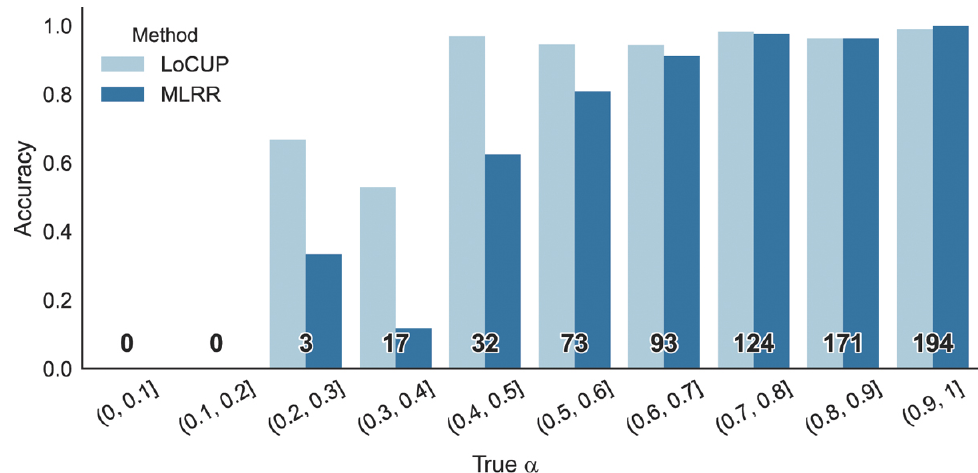
Figure 4: Accuracy for the LoCUP and MLRR methods binned by the true α of the simulated samples in D4. The num- ber of samples in each bin is shown in bold. Our method outperforms MLRR on samples where α ∈ (0, 2, 0.7), that is low- purity